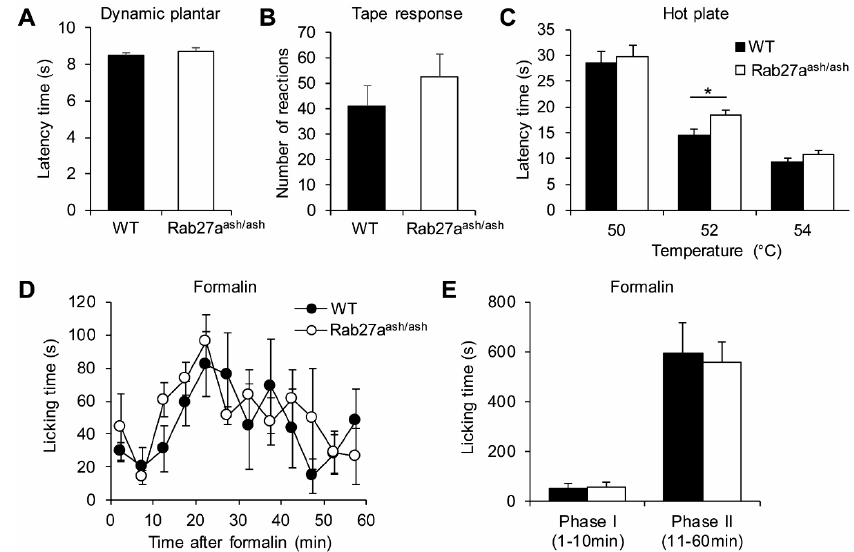
Figure 5. Rab27a ash / ash mice show normal responses in basal mechanical and nociceptive pain models. ( A–B ) Reaction to basal mechanical stimuli, as assessed by the Dynamic plantar test (A, n = 20 ‐ 22) or the tape response assay (B, n = 19) are not affected in Rab27a ash/ash mice. ( C ) Rab27a ash/ash mice show slightly reduced pain behavior in the hot plate test at 52 °C, while their responses at 50 °C and 54 °C were comparable to those of WT mice (C, n = 19). ( D–E ) Formalin ‐ induced nociceptive pain behavior is normal in Rab27a ash/ash mice ( n = 5 ‐ 6); * p < 0.05. Cells 2020 , 9 , x FOR PEER REVIEW